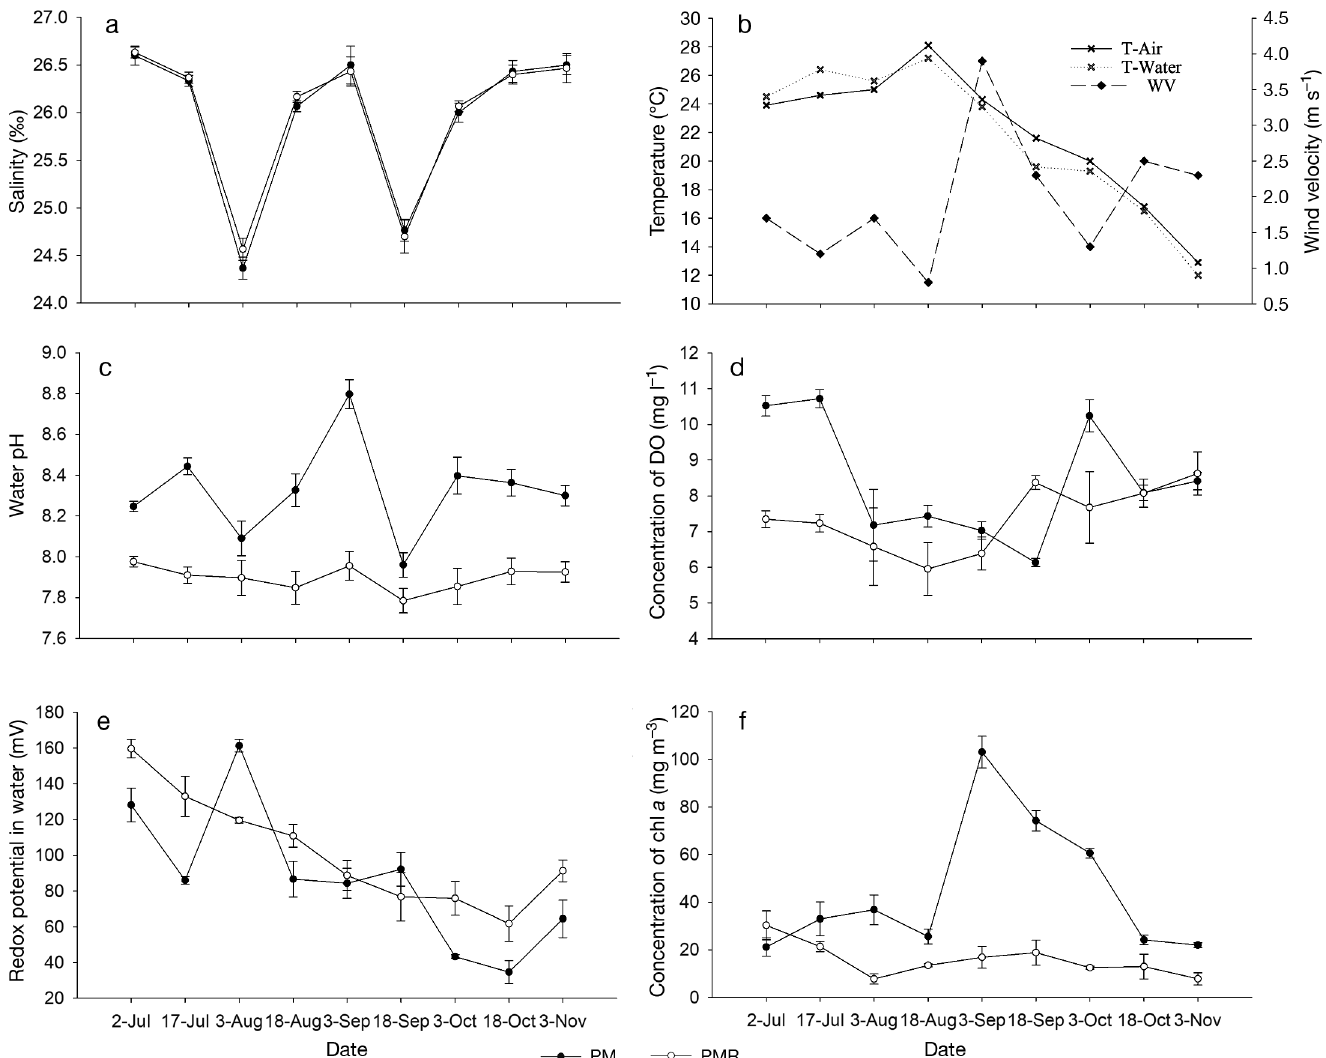
Fig. 1. Variations in salinity, wind velocity (WV), temperature (T), water pH, dissolved oxygen (DO), water redox potential and chl a in the PM and the PMR (defined in Table 1) during the farming seasons